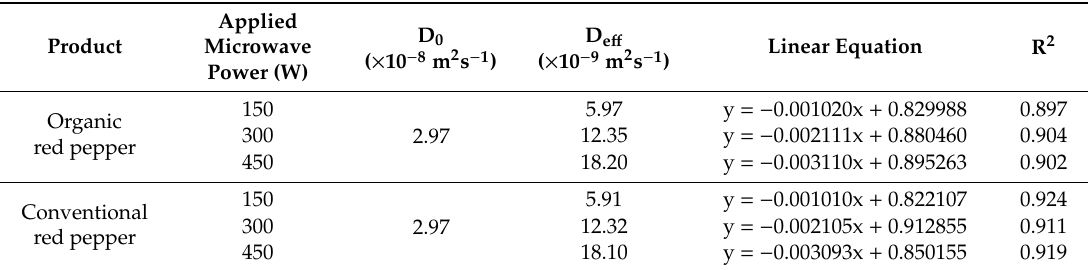
Table 6. E ff ective moisture di ff usion (D e ff ) coe ffi cients and equations for di ff erent applied intermittent Table 6. Effective moisture diffusion (D eff ) coefficients and equations for different applied intermittent microwave powers applied to organic and conventional sweet red microwave powers applied to organic and conventional sweet red peppers.